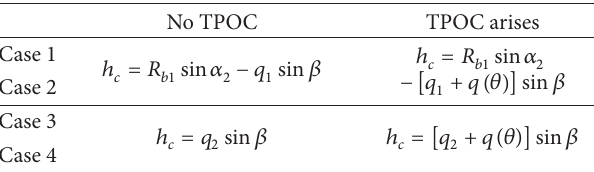
Table 2: ℎ 𝑐 before and after TPOC